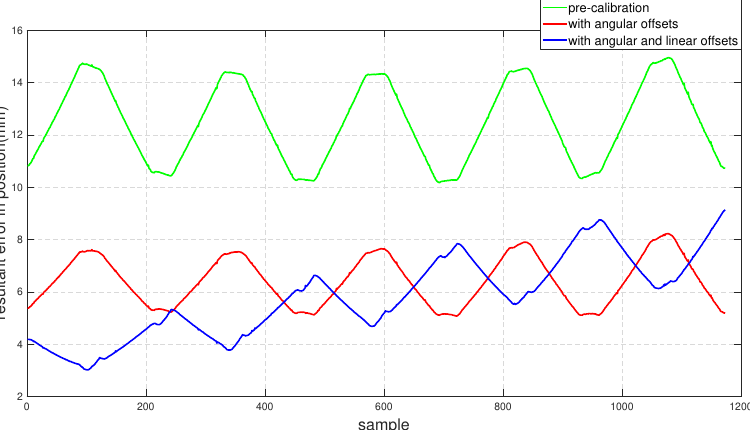
Figure 7. Resultant end-effector position error for the test set before and after calibration.